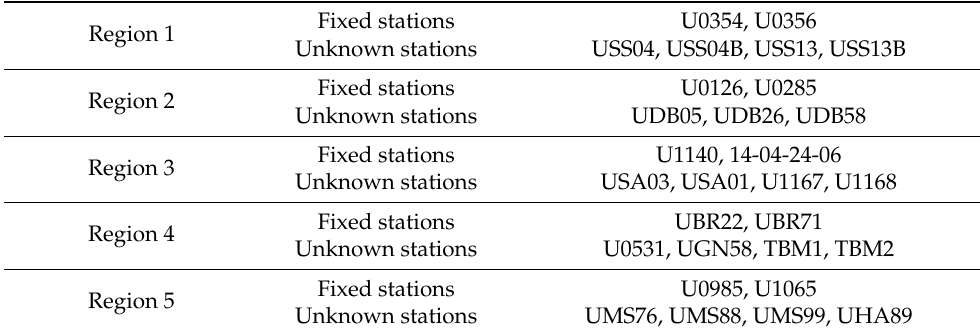
Table 2. List of surveying stations in the test